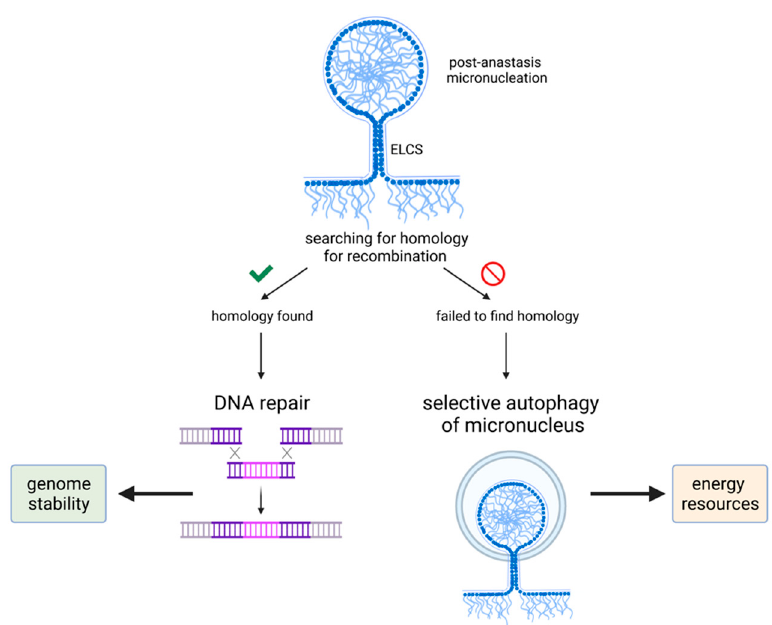
Figure 3. Micronucleus fate in surviving cells. Post-anastasis cells show the increased formation of micronuclei, which is a marker of DNA damage. However, micronuclei could contribute to maintaining genomic integrity by providing DNA material for homologous recombination or be used as a resource of energy in case of a failure to find sequence homology in micronuclei.